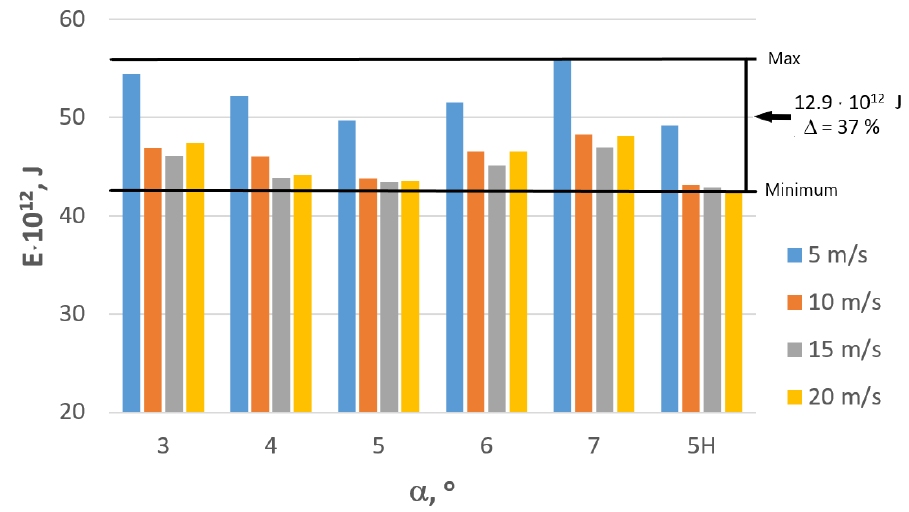
Figure 12. Influence of the technology of wire manufacturing on energy consumption in relation to the manufacturing of 100,000 tons of steel wire drawn with speed v = 5, 10, 15, 20 m/s. Using data presented in Table 2 and Figure 12, one can state that proper adjustment of the drawing process parameters, i.e., die geometry and drawing speed, allows for a substantial reduction of the energy consumption in the steel wire manufacturing process. The differences between analyzed variants amounted to approximately 37%, which in re- lation to an annual output of a wire factory translates to roughly 13 trillion Joules. It has been demonstrated that low drawing speed (close to 5 m/s) in the process of the zinc- coated steel wire drawing results not only in lower production efficiency but also in in- creased energy consumption, with the usage of high drawing angles exacerbating this phenomenon. Higher energy consumption translates to higher CO 2 emissions. Table 3 and Figures 13 – 15 demonstrate the influence of wire manufacturing technology on the CO2 emissions caused by electric power consumption. Table 3. CO 2 emissions related to the consumption of electric energy E required to manufacture 100,000 tons of 2.2 mm wire, depending on the drawing technology used, where — drawing angle, H — hydrodynamic dies, v — drawing speed.